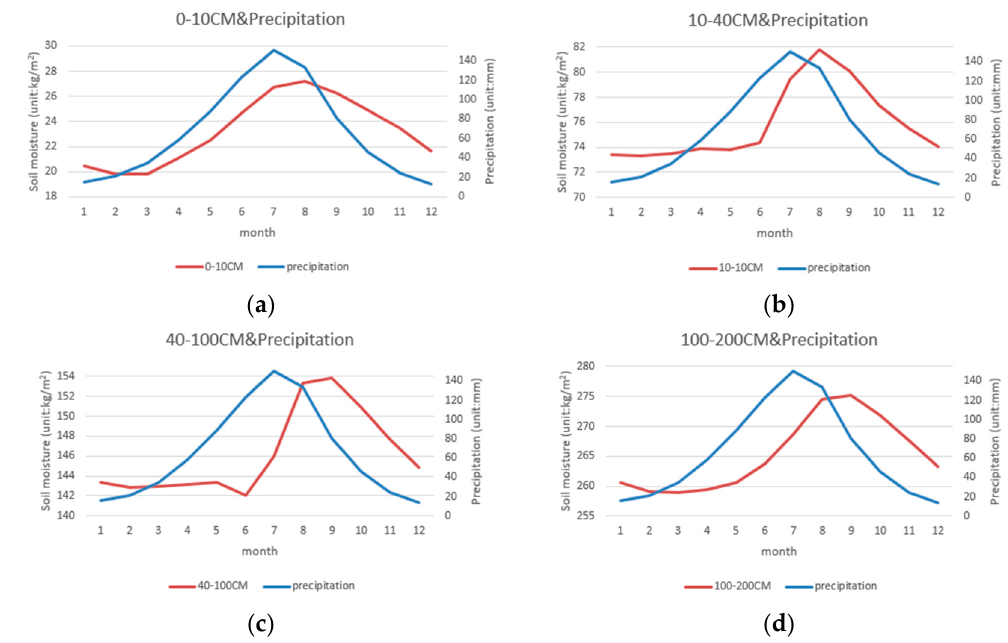
Figure 7. The evolution of each layer of soil moisture and precipitation in eastern China: ( a ) 0–10 cm and precipitation; ( b ) 10–40 cm and precipitation; ( c ) 40–100 cm and precipitation; ( d ) 100–200 cm and precipitation.